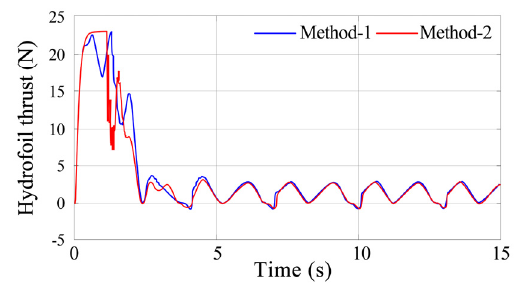
Figure 12. Hydrofoil thrust in horizontal direction.